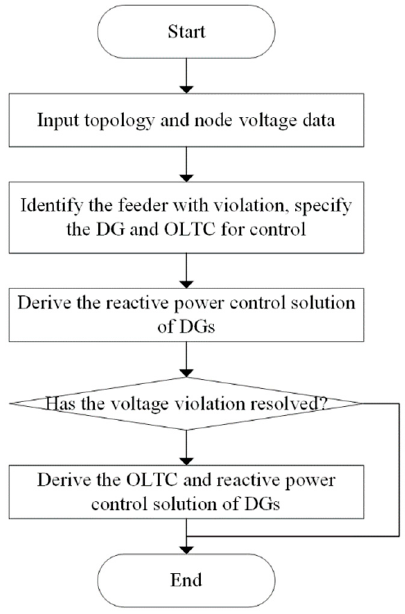
Figure 5. Flowchart of the voltage control process.